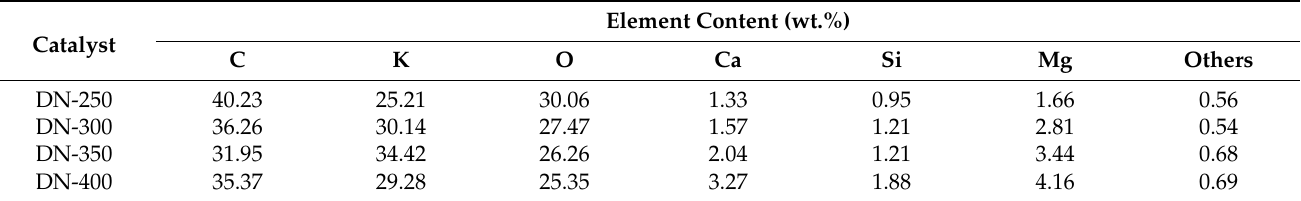
Table 3. EDX analysis of the reused